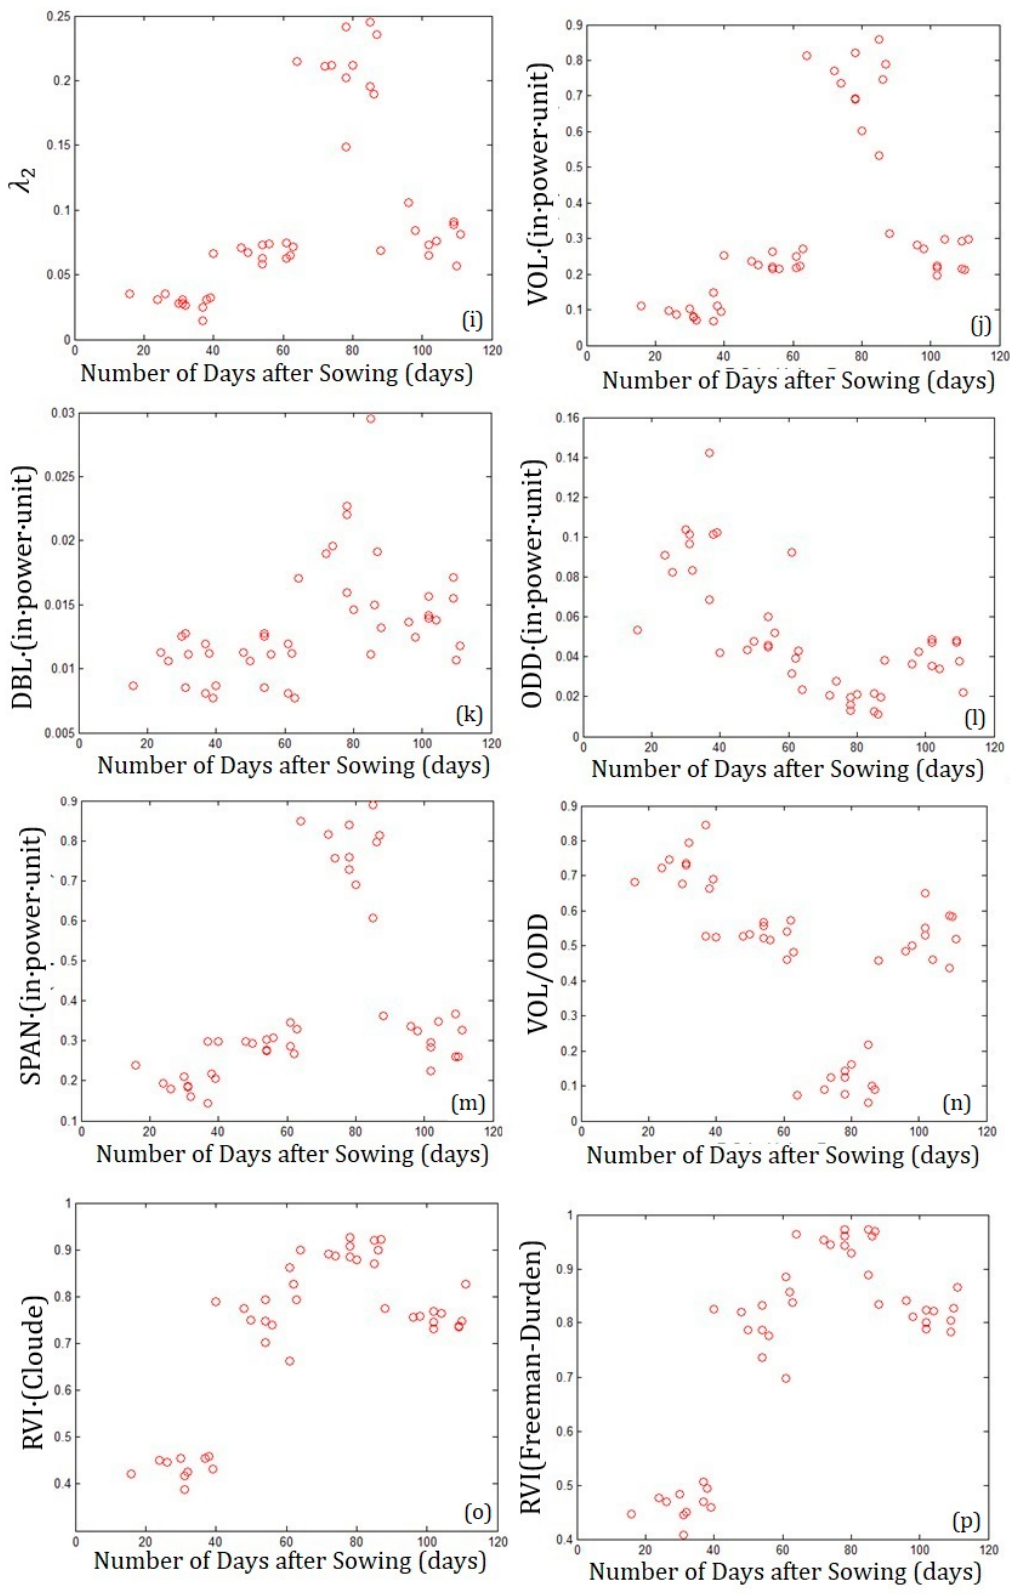
Figure 5. Temporal evolution of three growth parameters and 27 quad-polarimetric parameters based on 95 plots during the entire growth cycle of rape. ( a ) Leaf area index (LAI); ( b ) stem height; ( c ) biomass. The following scatter plots are the representative quad-polarimetric parameters.